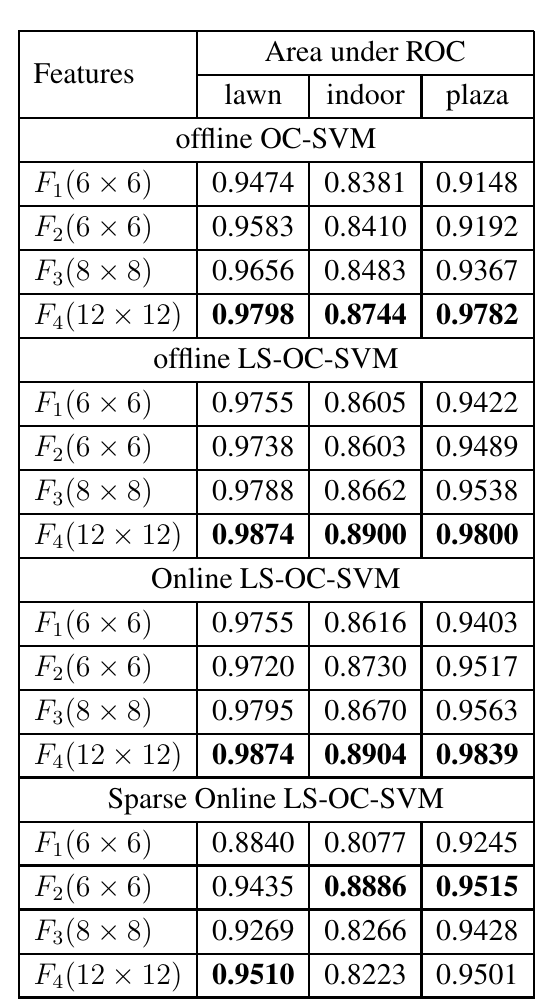
Table 2. AUC of the abnormal event detection method based on covariance descriptors constructed by different features F via OC-SVM (Section 3.1), original LS-OC-SVM learning training samples together offline (Section 3.2), online LS-OC-SVM (Section 3.3) and sparse online LS -OC-SVM (Section 3.4). The biggest value of each method is shown in